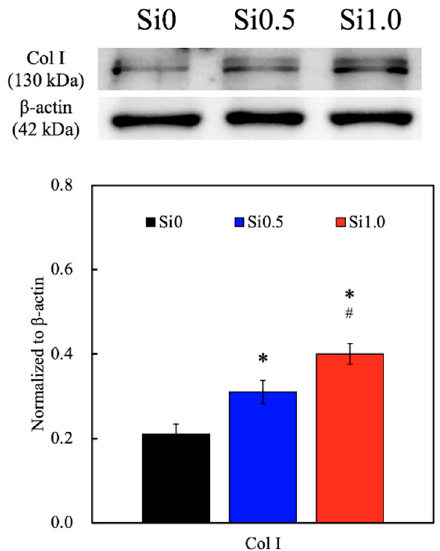
Figure 8. Western blot and quantification results of the Col I synthesis from hDF cultured on Si-GelMa hydrogels for 3 day. “*” indicates a significant difference ( p < 0.05) compared with Si0. # indicates a significant difference ( p < 0.05) from Si0.5.